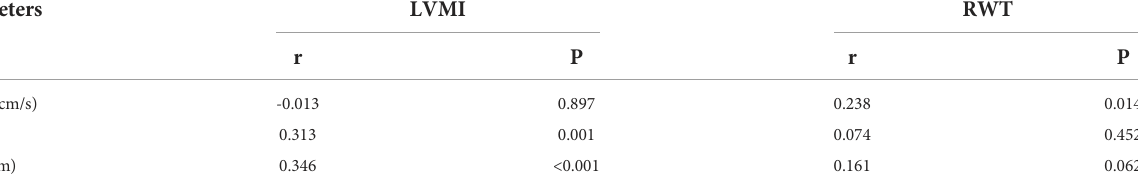
TABLE 2 Correlation of vascular parameters with LVMI and RWT.